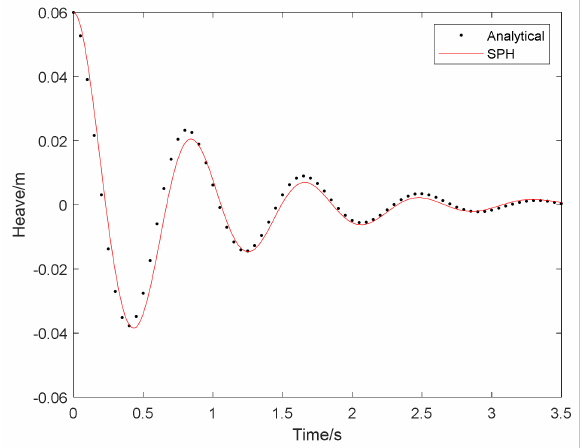
Figure 3. Comparison of the analytical and numerical heaves for the decay